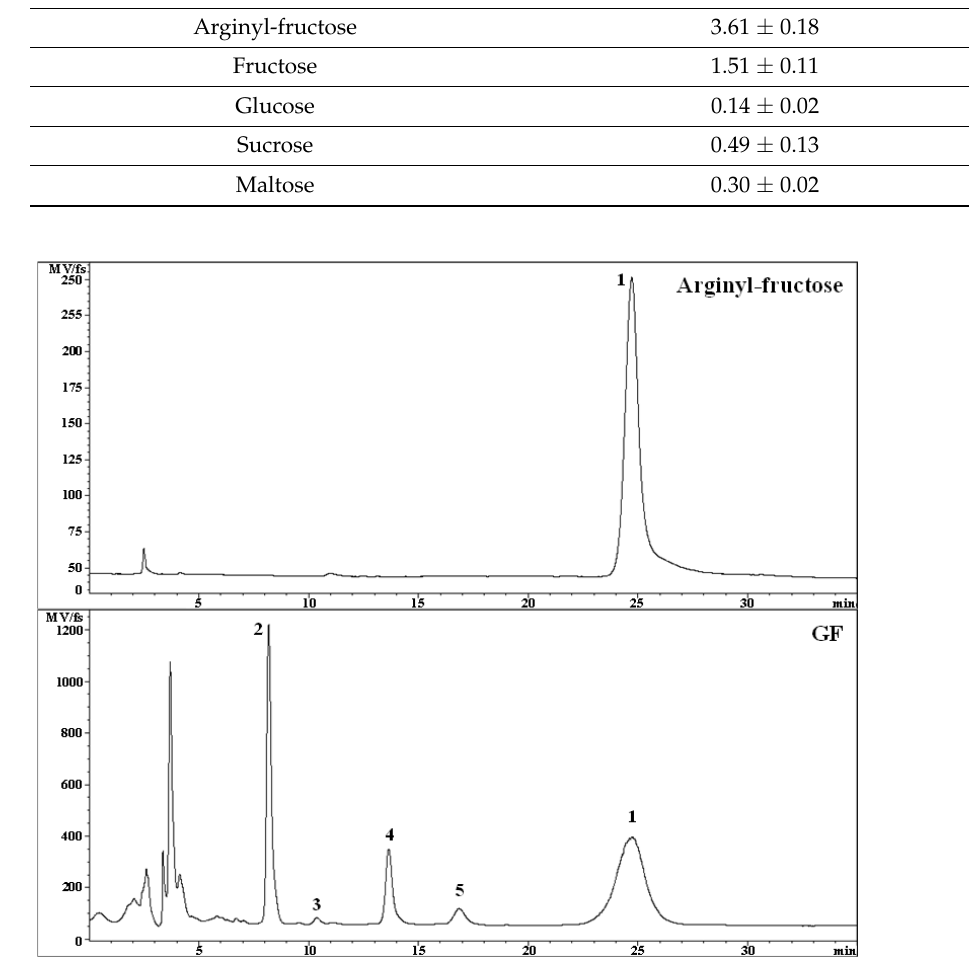
Figure 1. HPLC Analysis of GF components using ELSD ( 1 : Arginyl-fructose (AF), 2 : Fructose, 3 : Glucose, 4 : Sucrose, 5 : Maltose).